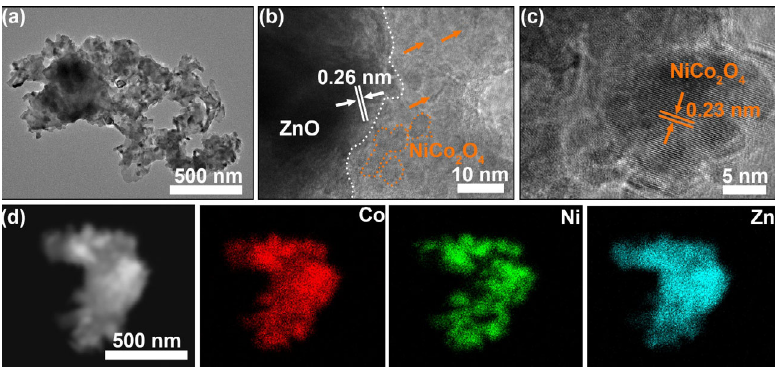
Fig. 2 TEM and high resolution TEM (HRTEM) images of the ZnO/NiCo 2 O 4 -7 nanoparticles: (a) TEM, (b, c) HRTEM, and (d) EDS